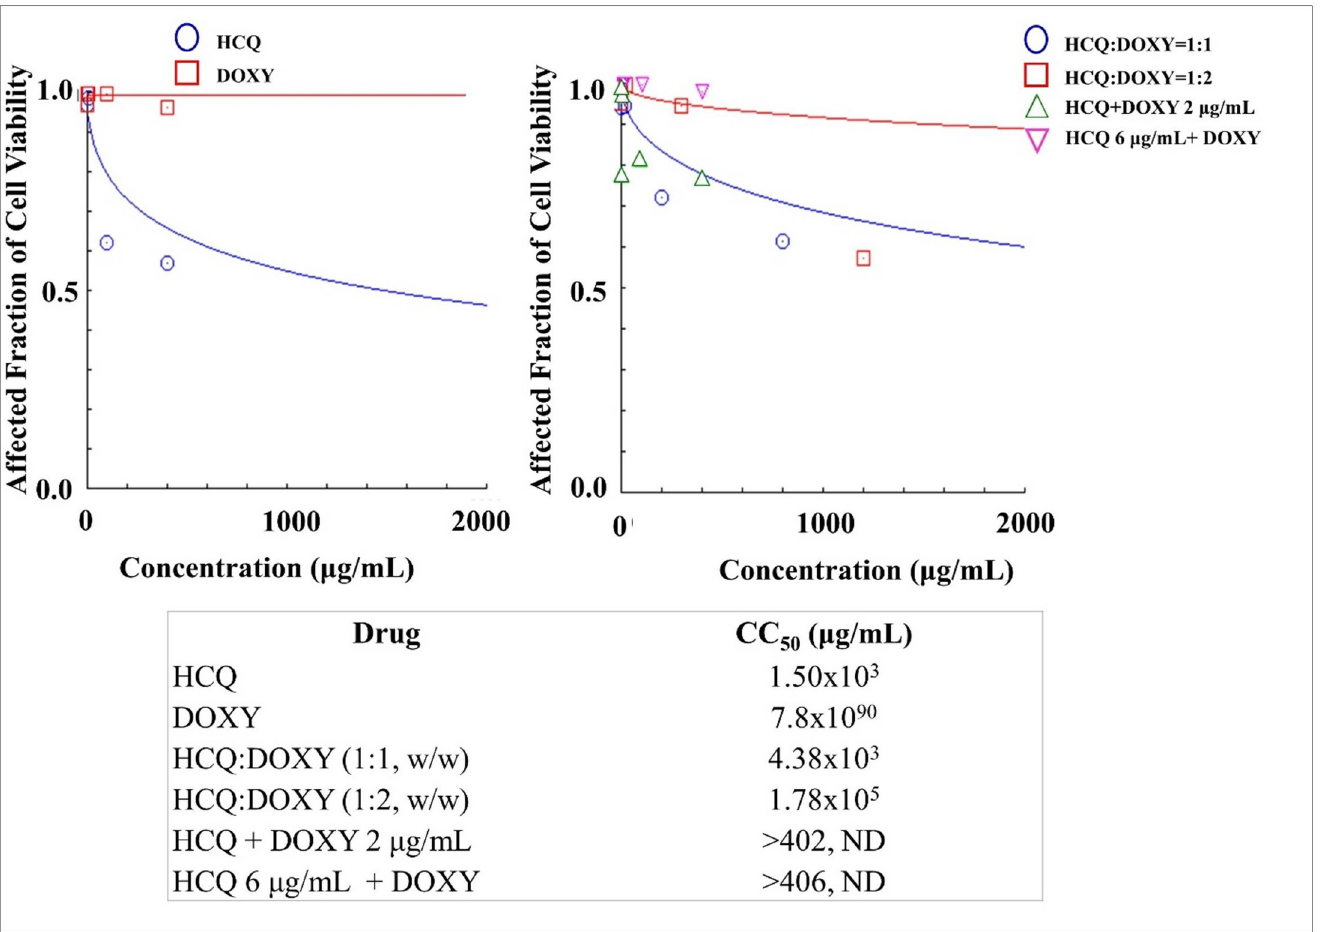
Fig 8. The cytotoxicities of Hydroxychloroquine (HCQ) and Doxycycline (DOXY) as a single drug (left) and dual drug combination in constant and non- constant ratios (right) analysed by using CompuSyn Software (n = 3). At non-constant ratios of HCQ + DOXY 2 μ g/mL, DOXY was added at a concentration of 2 μ g/mL to each increased levels of HCQ i.e. 0.2, 2, 10, 100, and 400 μ g/mL. On the other hand, HCQ was then added at a concentration of 6 μ g/mL to each increased levels of DOXY i.e. 0.2, 2, 10, 100, and 400 μ g/mL to produce HCQ 6 μ g/mL + DOXY. AZI (1:2) resulted in an IC of less than 8.33 ppm for 24-hour incubation which was lower 50 than those of single use LOPIRITO and AZI which were 12.10 and 51.90 μ g/mL respectively. LOPIRITO + CLA (1:1) also produced a similar result at 24 hours post-incubation with a lower IC value, at 6.90 μ g/mL, than those of single LOPIRITO and CLA at 12.10 and 4.60 μ g/mL. A 50 drug combination of LOPIRITO + DOXY (1:1) lowered the IC of DOXY at 24 hours after 50 drug incubation, which was reduced from 18 μ g/mL as a single drug to 13.94 μ g/mL as a dual drug combination. On the other hand, the combination of HCQ with AZI, DOXY, FAVI, and LOPIRITO increased the IC values against their single drug uses, as well as the combination 50 of FAVI + AZI (2:1).